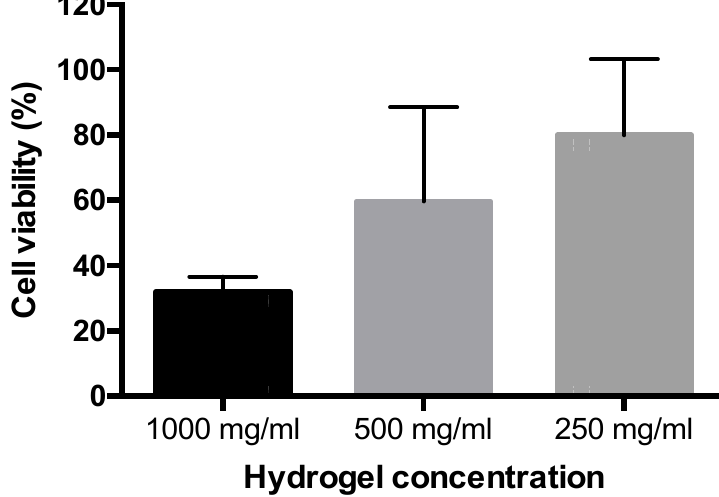
Figure 4. Effect of ascorbyl palmitate (AP) hydrogel on Caco-2 cell viability. AP hydrogel was applied to cells for two h at different concentrations in Hank’s Balanced Salt Solution. Viability was measured via the AlamarBlue reagent. Data shown as mean ± SD ( n = 3).